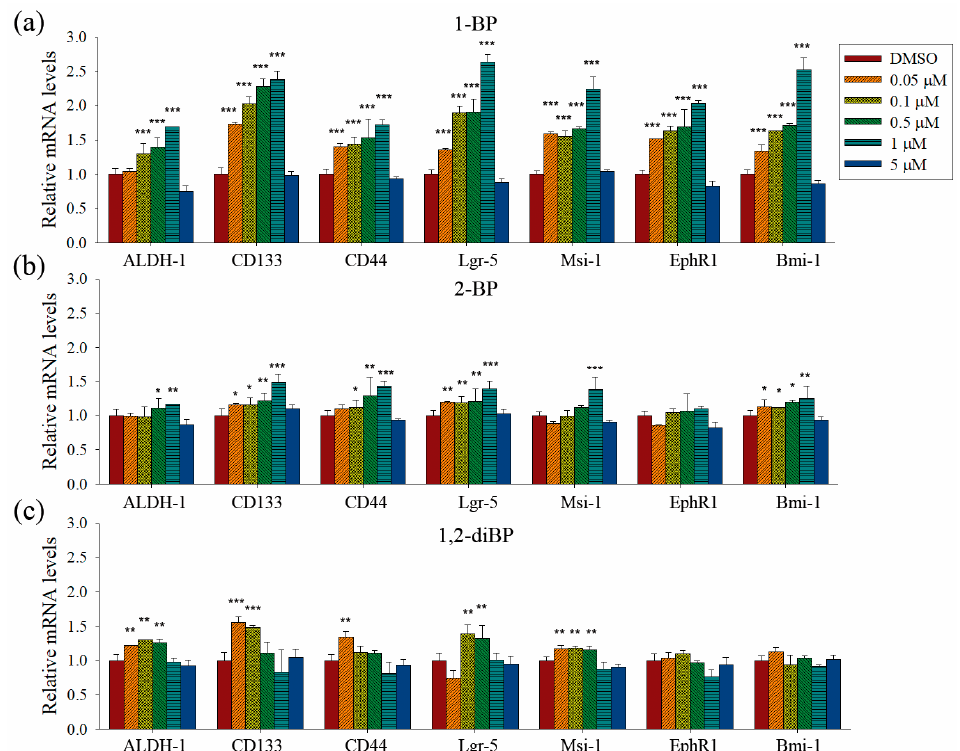
Figure 4. The effects of BP compounds on the mRNA expression of cancer stemness markers. CSC221 cells were treated with various concentrations of 1-BP ( a ), 2-BP ( b ), or 1,2-diBP ( c ) for 48 h. Total RNA was prepared, cDNA was synthesized, and real-time PCR was performed with the primers listed in Materials and Methods. Data represent the relative mRNA expression levels compared with the untreated control groups for each target gene. Data represent the mean ± SEM and were analyzed by one-way ANOVA. * p < 0.05, ** p < 0.01, and *** p < 0.001 vs. the untreated control groups of each target gene.